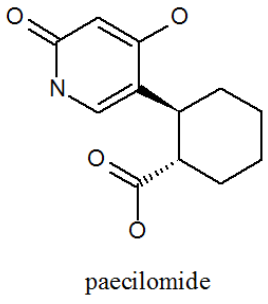
Figure 4. The structure of paecilomide.